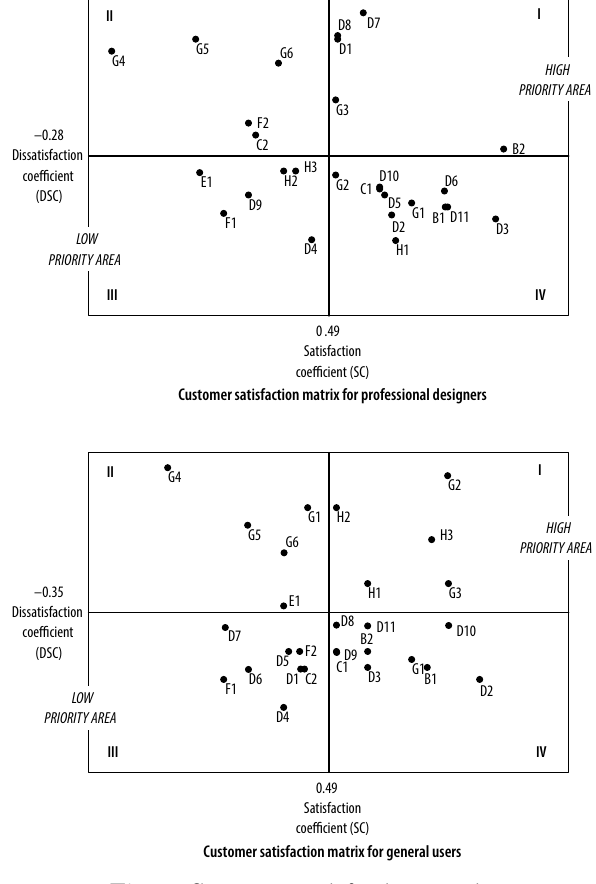
Fig. 3. Customer satisfaction